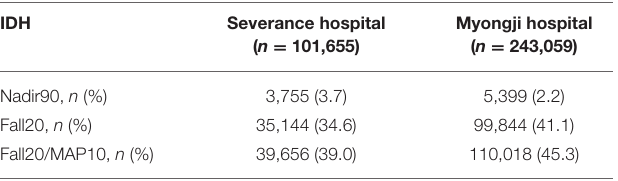
TABLE 2 | Number of events among segments according to the definitions of intradialytic hypotension.